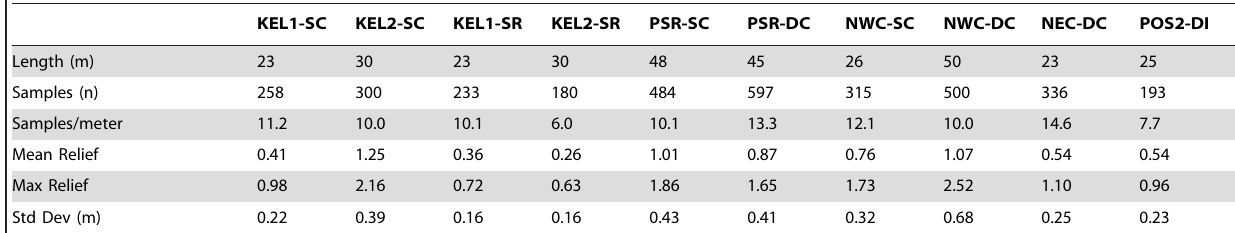
Table 3. Digital Reef Rugosity sampling statistics.